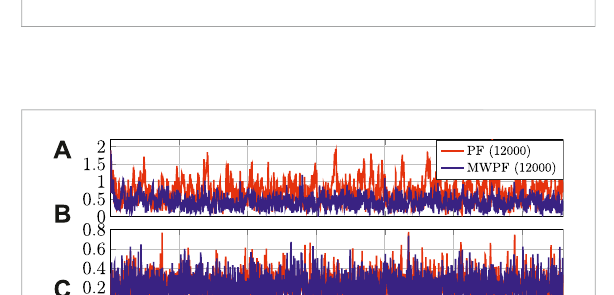
FIGURE 8 Comparison of PF and MW-PF solutions (in east-north referenceframe)appliedtopositionestimationofadynamicGNSS receiver.